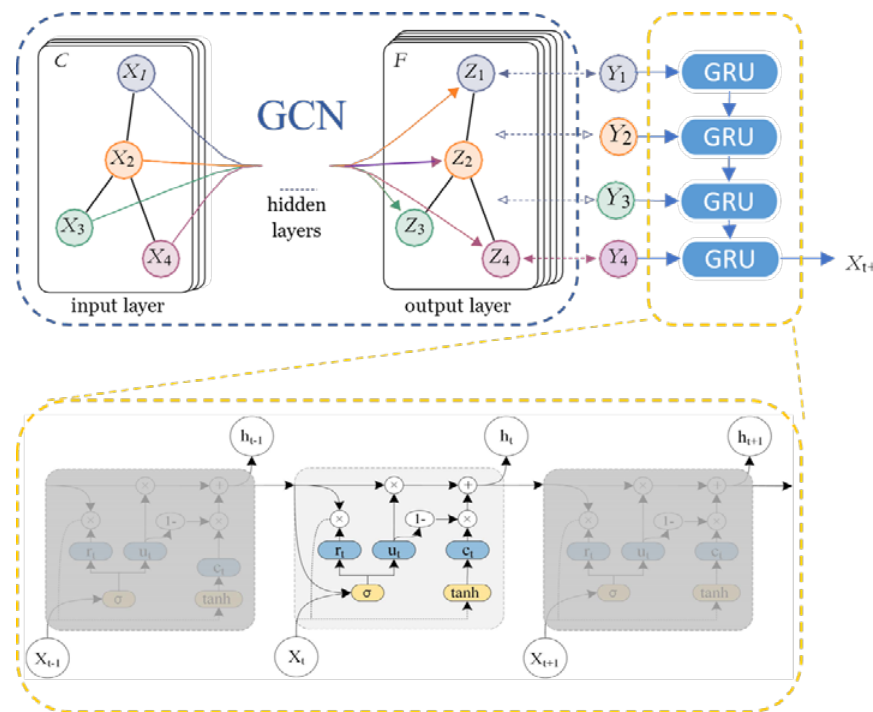
Fig. 3. Overview. We use the historical sensor feature as an input and the Graph Convolution Network (GCN) and Gated Recurrent Unit (GRU) model to reach the final prediction